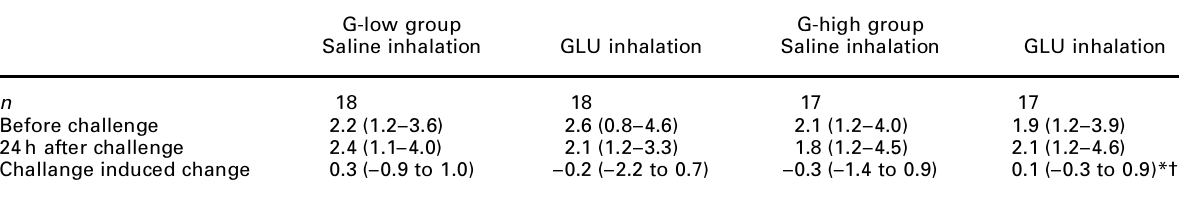
Table 4. The numbers of lymphocytes ( ´ 10 9 /l) in blood before and 24h after saline and (1 ® 3)- b - D -glucan (GLU) inhalations G-low